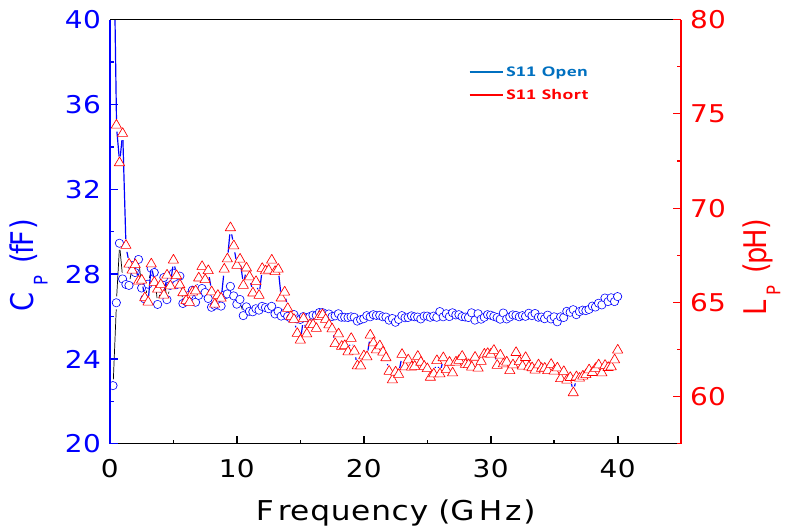
Figure 16. Measured S 11 for open (blue) and short (red) patterns.